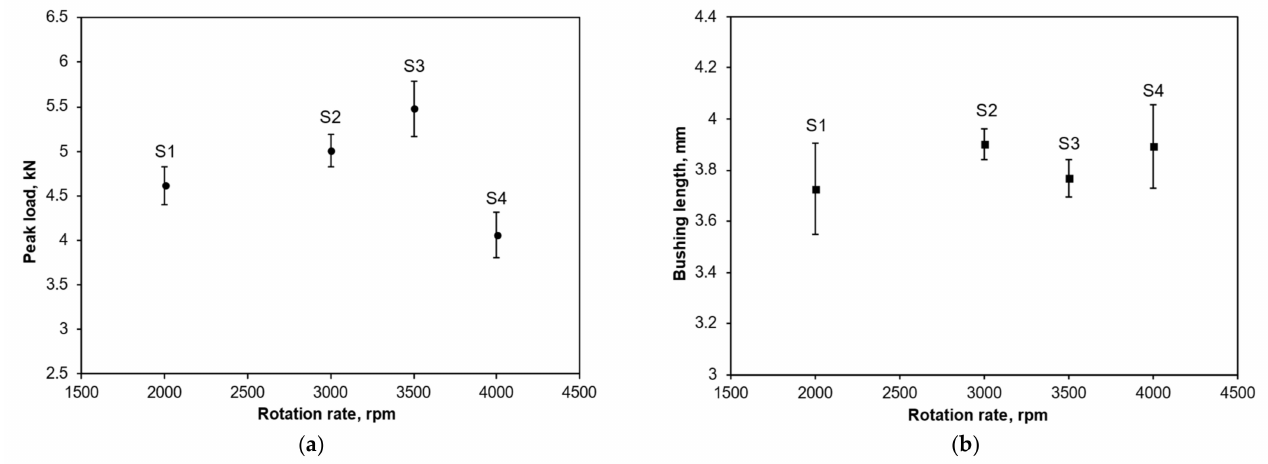
Figure 5. Comparison of ( a ) the average peak load and ( b ) the bushing lengths for all scenarios. The error bars indicate the standard errors.